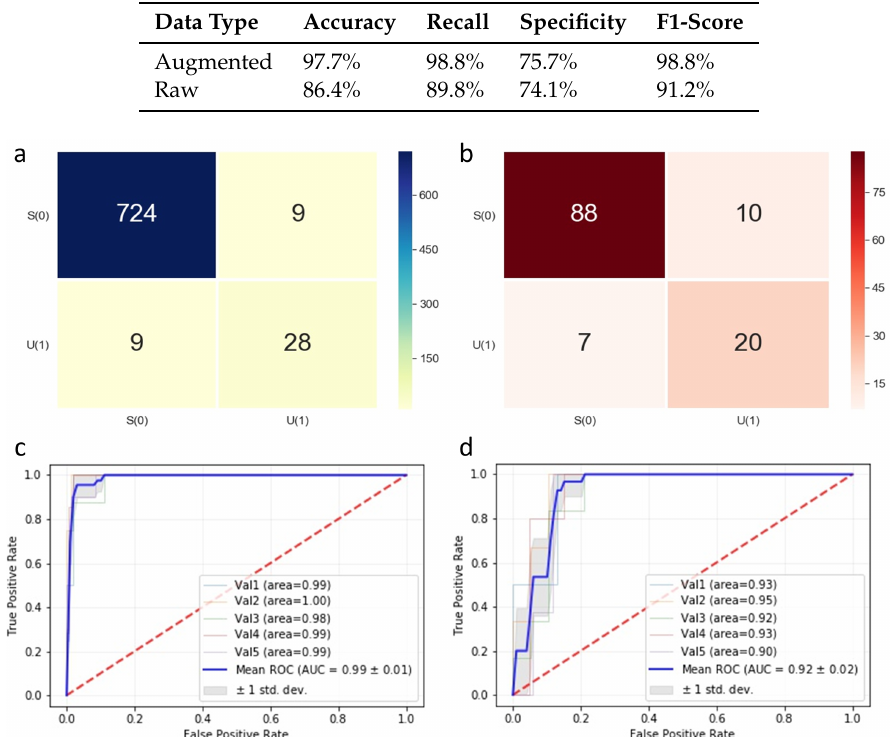
Table 6. Accuracy, recall, specificity and f1-score for augmented and raw data.